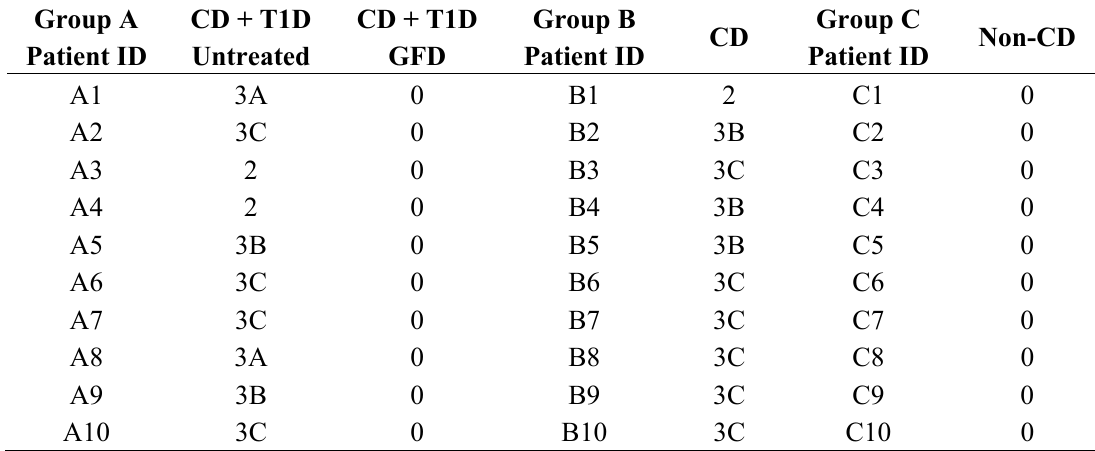
Table 1. Biopsy Marsh scores for individual patients. Group A consists of patients with both celiac disease (CD) and type 1 diabetes, so each patient has two scores: untreated and after remission (GFD). Group B patients have CD only, and Group C patients do not have CD (normal biopsies), but may have other